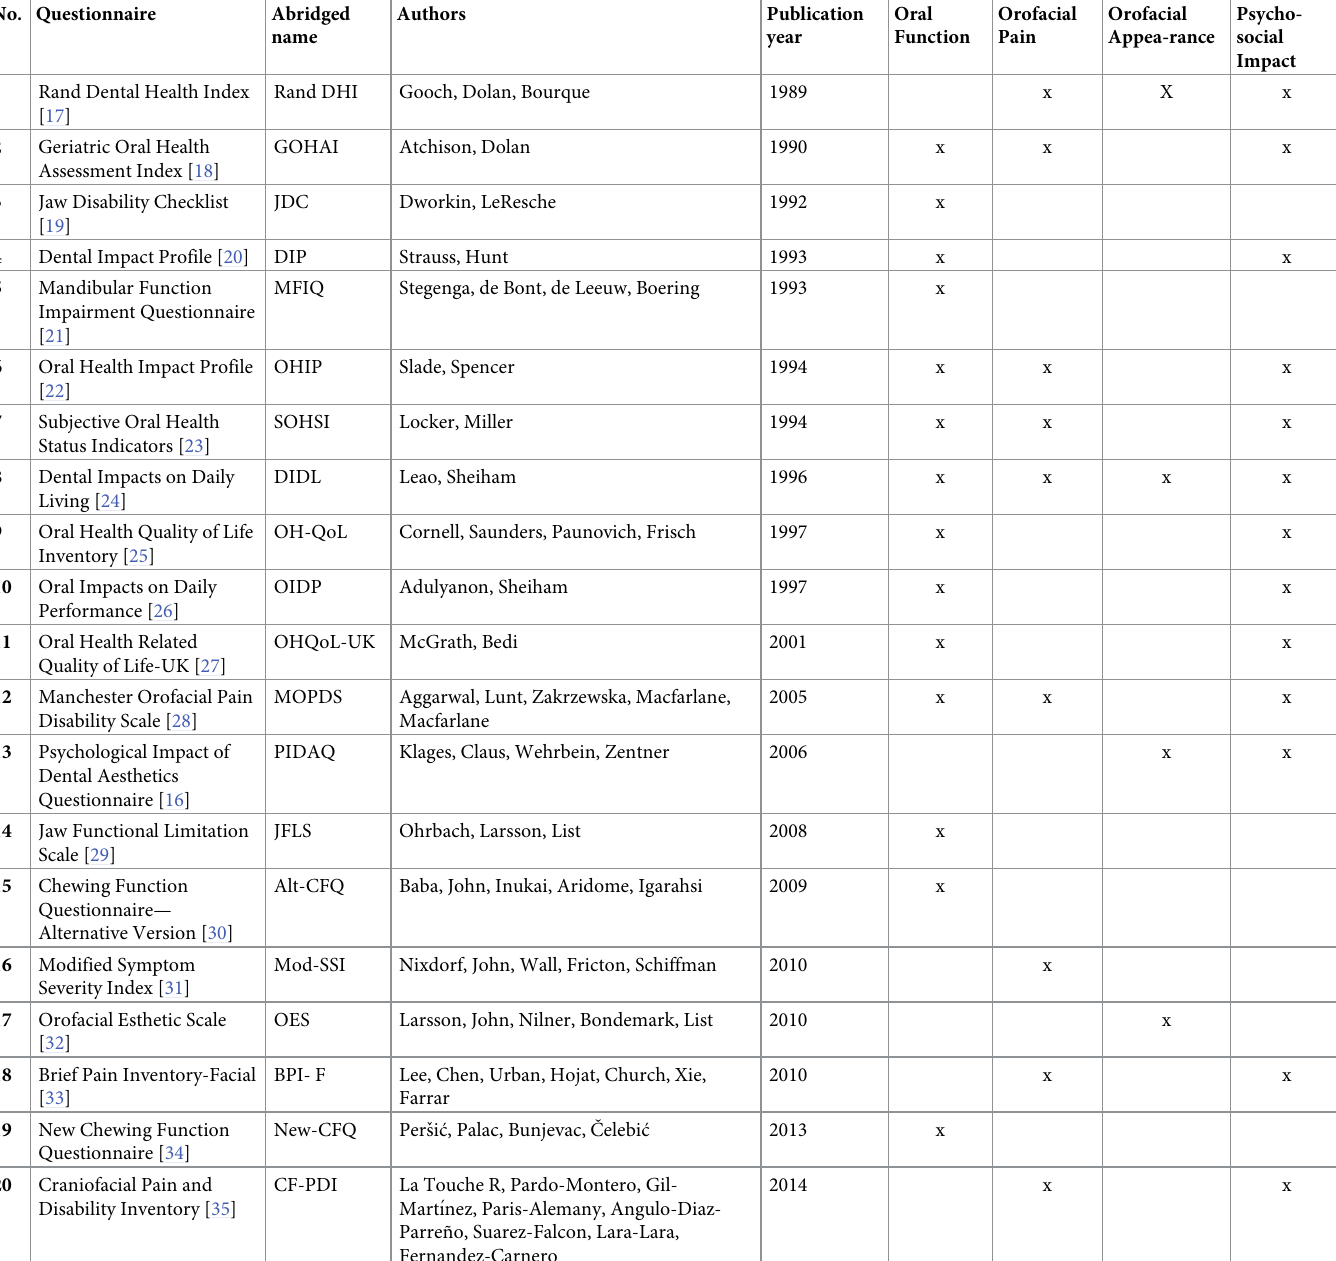
Table 1. dPRO questionnaires measuring OHRQoL dimensions. ”x” indicates a median expert rating � 5 points and � 2 points within the highest dimension rating. Empty cells indicate median expert ratings > 2 points lower than the highest dimension rating. No.